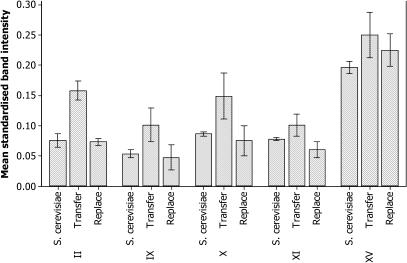
Results of Pulsed Field Gel Image AnalysisThe graph shows the mean standardized band intensities (a measure of the fraction of total cell DNA) for the five targeted S. paradoxus chromosomes that comigrate to the same bands as their S. cerevisiae homeologs. The error bars represent 95% confidence intervals. Four independent replicates were produced for Chromosomes II, IX, X, and XI. Ten independent replicates were produced for Chromosome XV. Raw images of all the gels as well as a table of all the image data are included in Figures S1–S5 and Table S1.